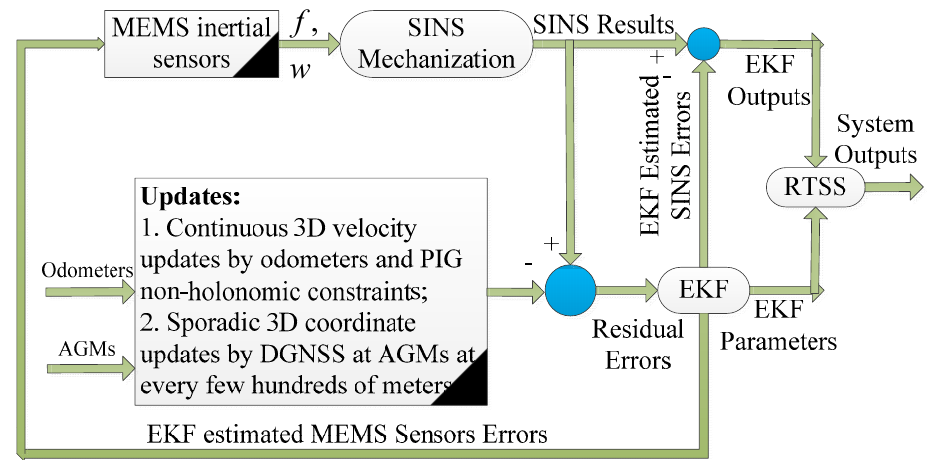
Figure 7. Schematic of Strapdown Inertial Navigation System (SINS) / Odometer (Odo) / Above Ground Marker (AGM)-based intelligent PIG surveying technology.